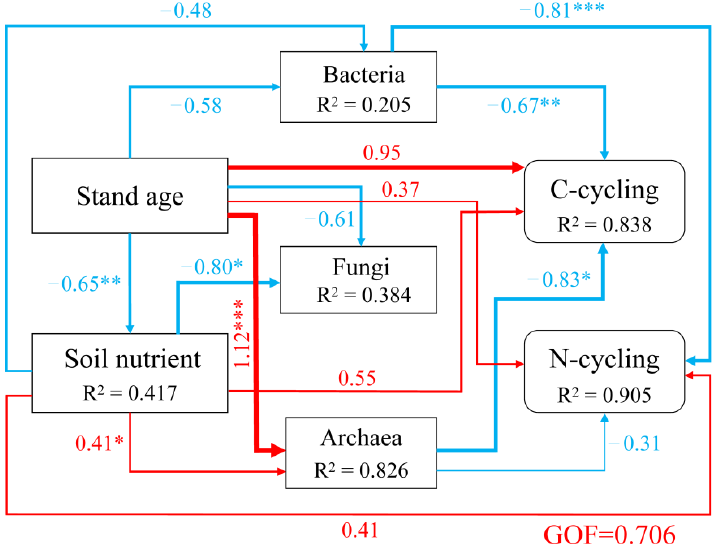
Figure 7. Partial least-squares path models (PLS-PM) showing the effects of stand ages,